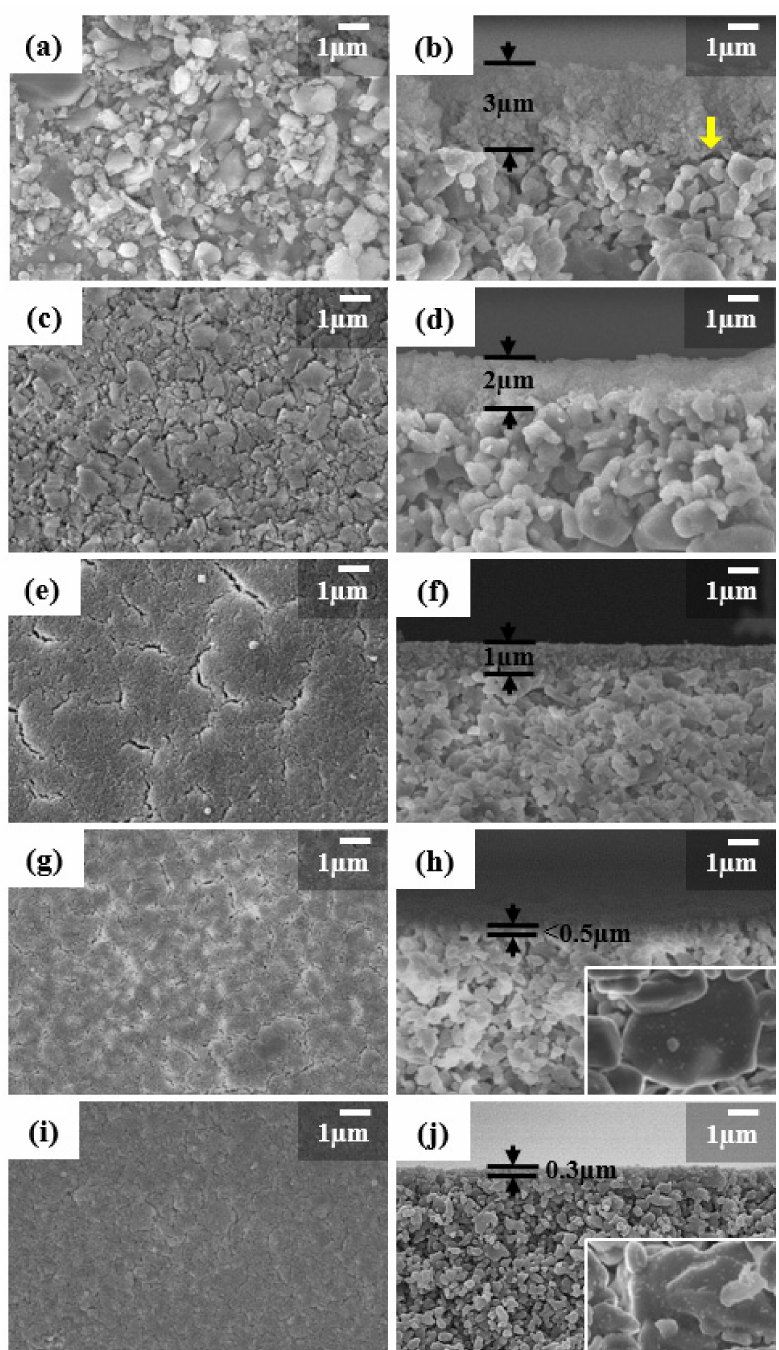
Figure 4. Surface and cross-section SEM images of seeded supports using planetary-milled seeds with average particle size of ( a , b ) S1 = 300 nm, ( c , d ) S2 = 250 nm, ( e , f ) S3 = 200 nm, ( g , h ) S4 = 140 nm and ( i , j ) S5 = 120 nm. The yellow arrow shows detachment of seed